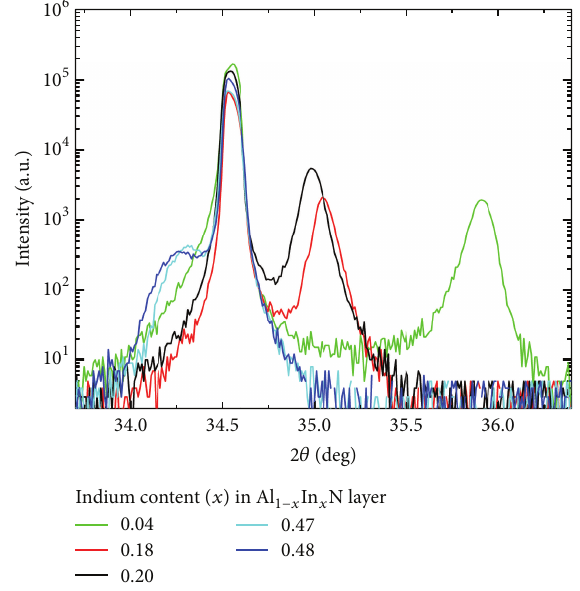
Figure 3: HR-XRD 2 𝜃 - 𝜔 scans of the (0002) reflection of the AlInN/GaN/Al 2 O 3